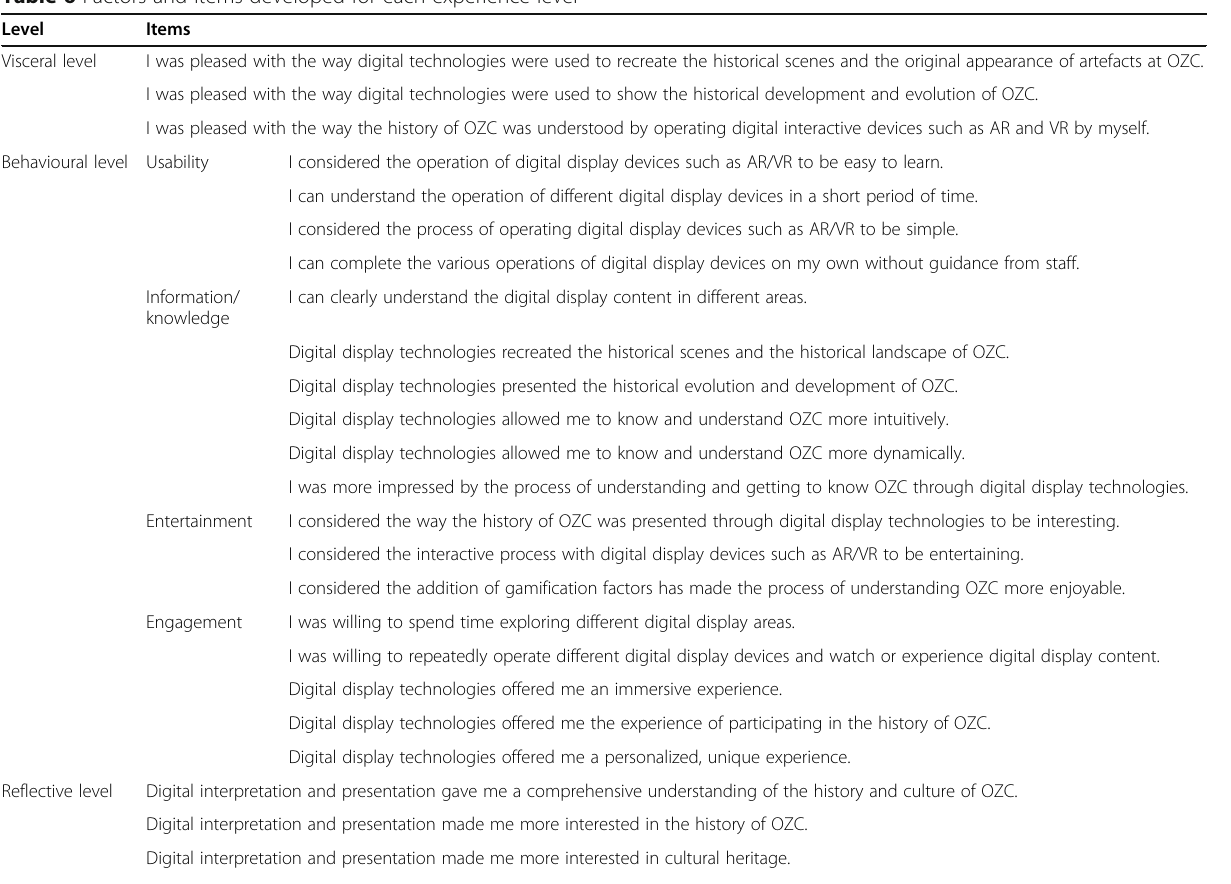
Table 6 Factors and items developed for each experience level Level